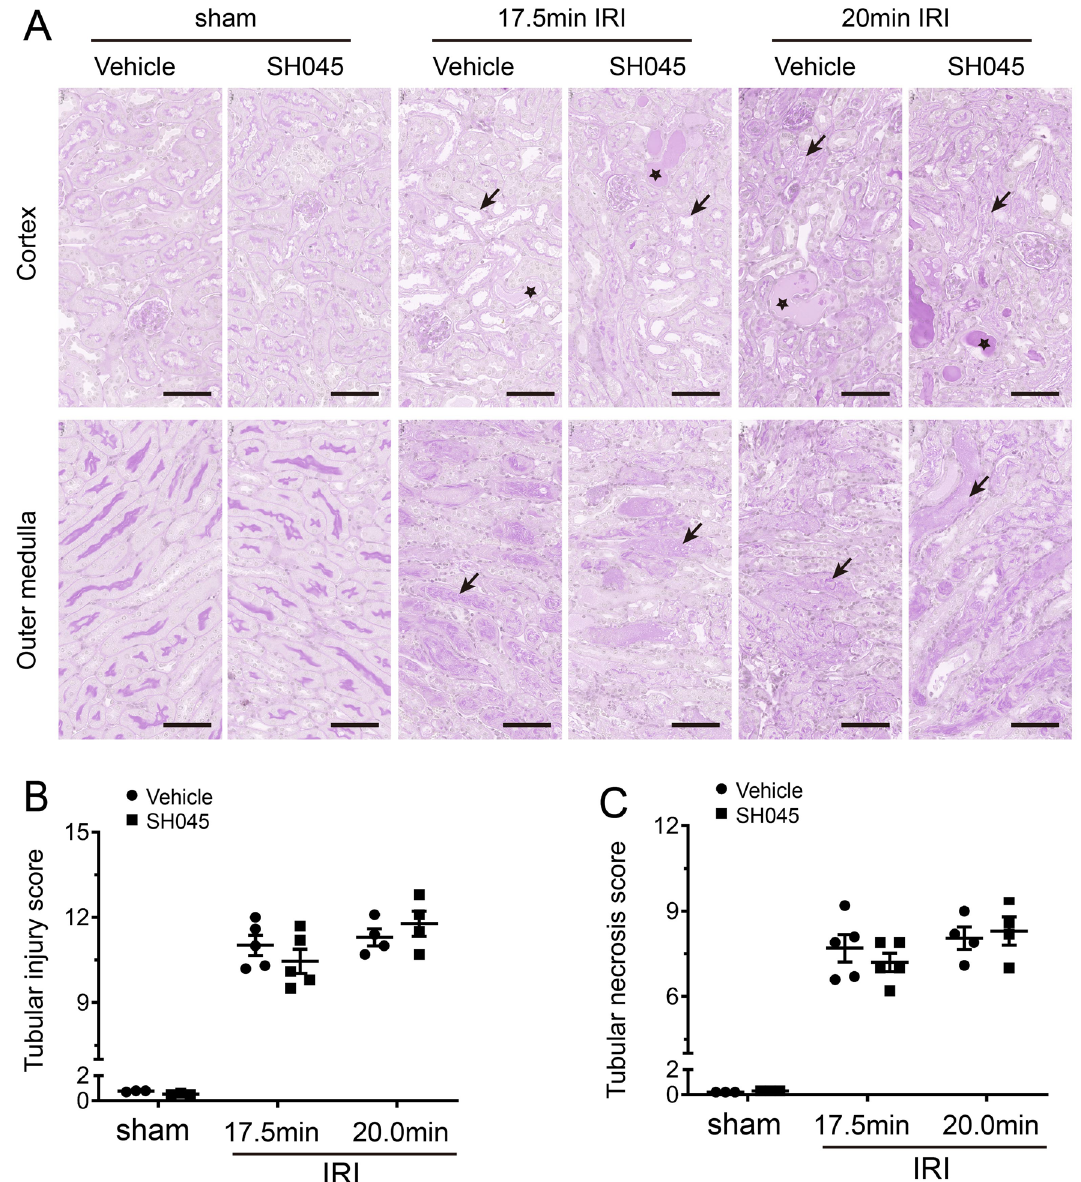
Figure 6. SH045 effects on kidney histopathology after renal ischemia reperfusion–induced AKI. ( A ) Representative cortical or outer medullary images of IRI-injured kidneys isolated from mice injected with vehicle or Trpc6 blocker SH045 (magnification: 400 ×). Kidneys sections/slices were stained with Periodic Acid- Schiff staining (PAS). Arrows indicate tubular injury. Stars indicate tubular casts. Scale bars are 100 µm. ( B ) The semi-quantification of cortical tubular injury. ( C ) The semi-quantification of outer medullary tubular necrosis. Data expressed as means ± SEM (Sham n = 3 each, 17.5 min-IRI in vehicle and SH045 n = 5 each, 20 min-IRI in vehicle and SH045 n = 4 each, respectively). Two-way ANOVA followed by Sidak’s multiple comparisons post hoc